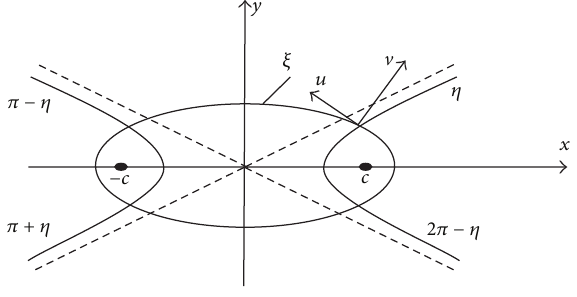
Figure 4: Elliptic coordinate